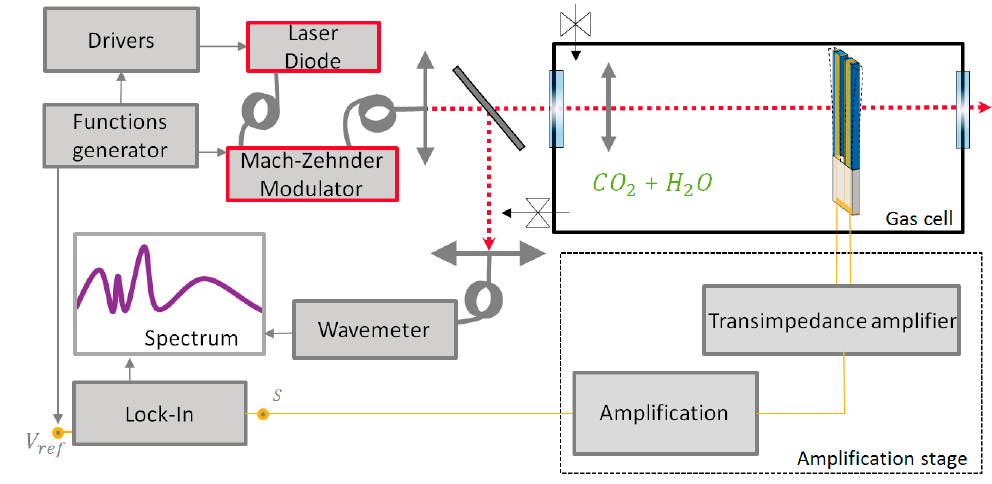
Figure 2. Detection scheme for QEPAS CO 2